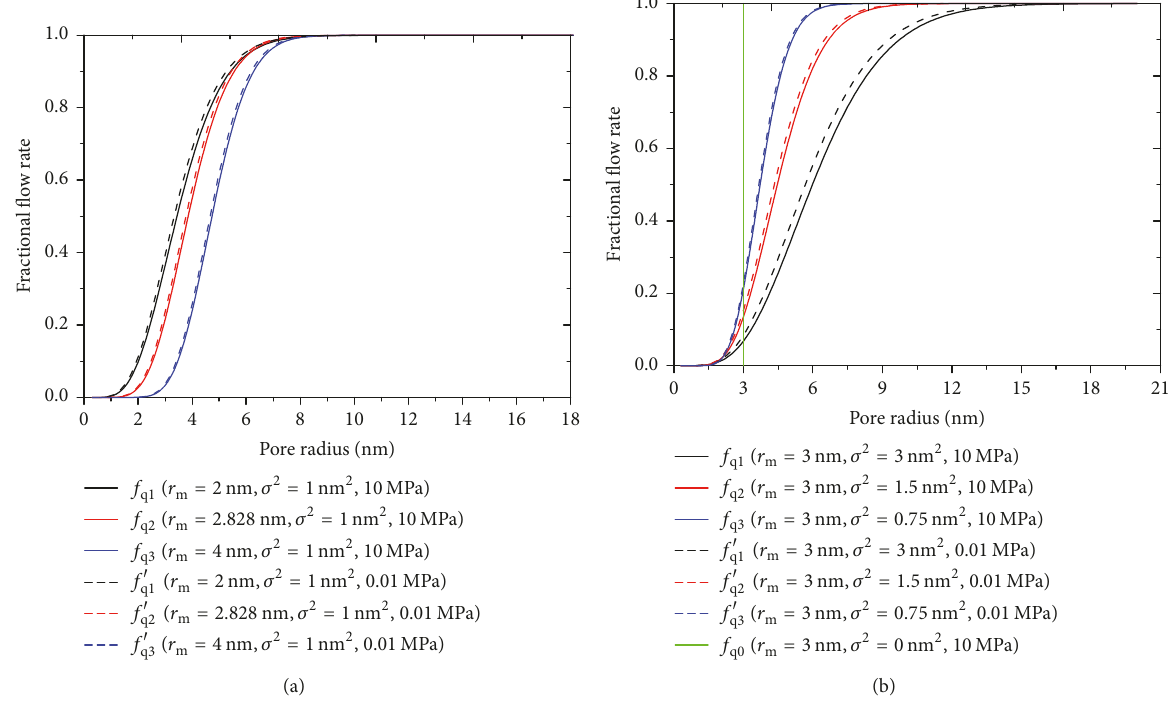
Figure 6: Fractional flow rate as a function of pore radius. The lines are calculated from (13). The parameter set is presented in Table 2. (a) The effect of 𝑟 on the fractional flow rate. (b) The effect of 𝜎 2 on the fractional flow m